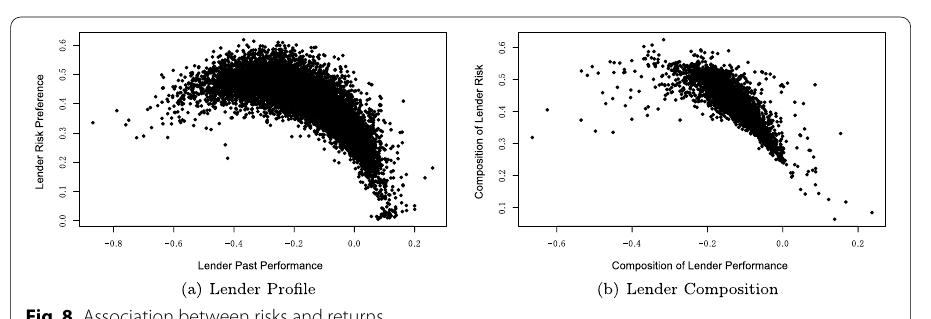
Fig. 7 Distribution of loans’ lender composition metrics